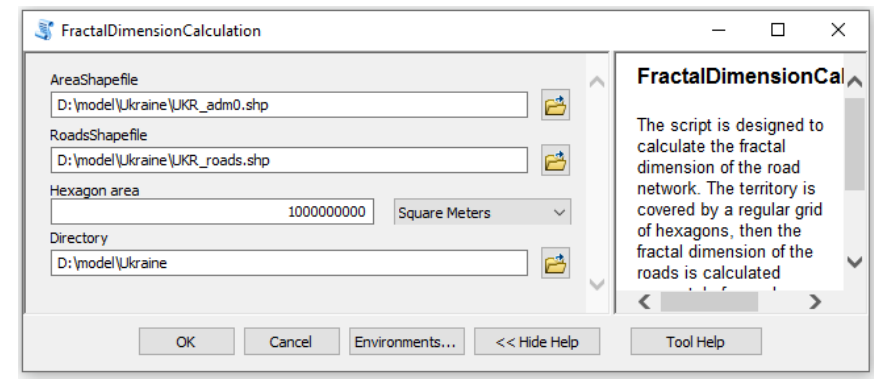
Figure 3. Python script interface.